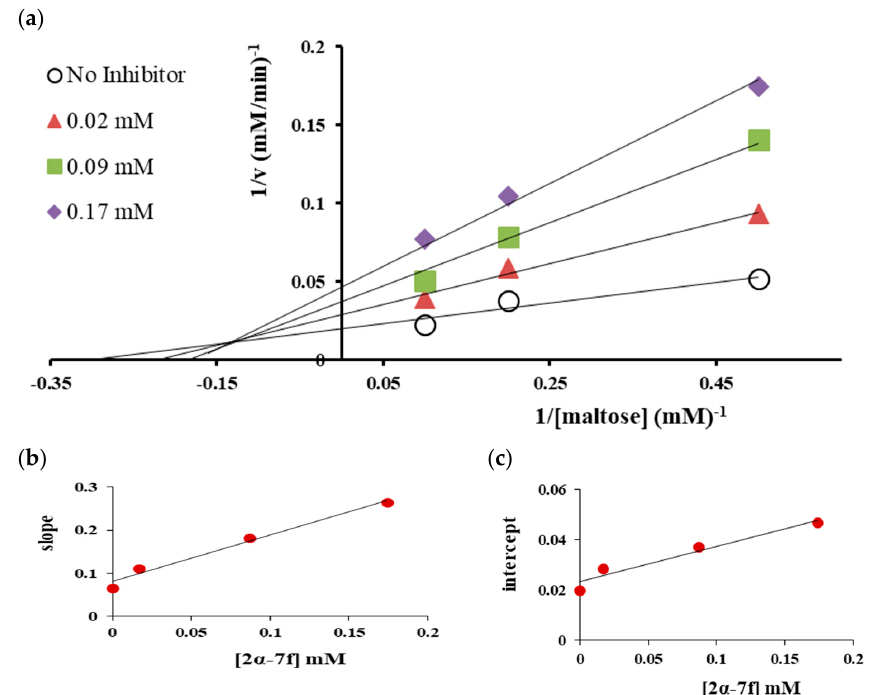
Figure 9. Lineweaver–Burk plots for inhibitory activity of 2 α -7f against rat intestinal maltase ( a ). Secondary replots of ( b ) slope vs. [I] and ( c ) intercept vs. [I] from a primary Lineweaver–Burk plot for the determination of K i and K’ i , respectively.